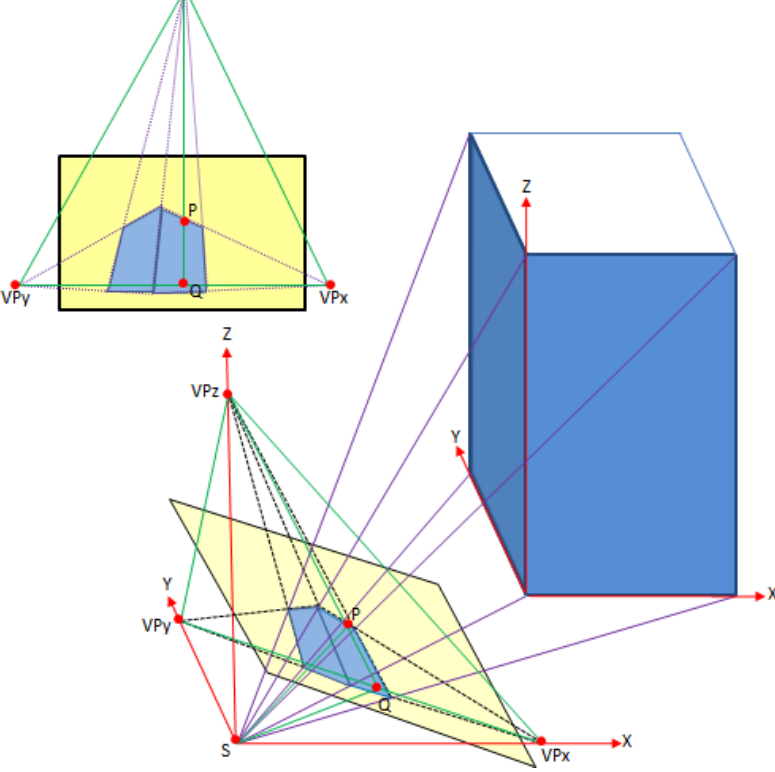
Figure 3. Vanishing point geometry: S , point of view; P , principal point; ( VPx , VPy , VPz ), vanishing points; VPx , VPy , horizon line; PVPz , maximum slope line; Q , intersection of the maximum slope and horizon